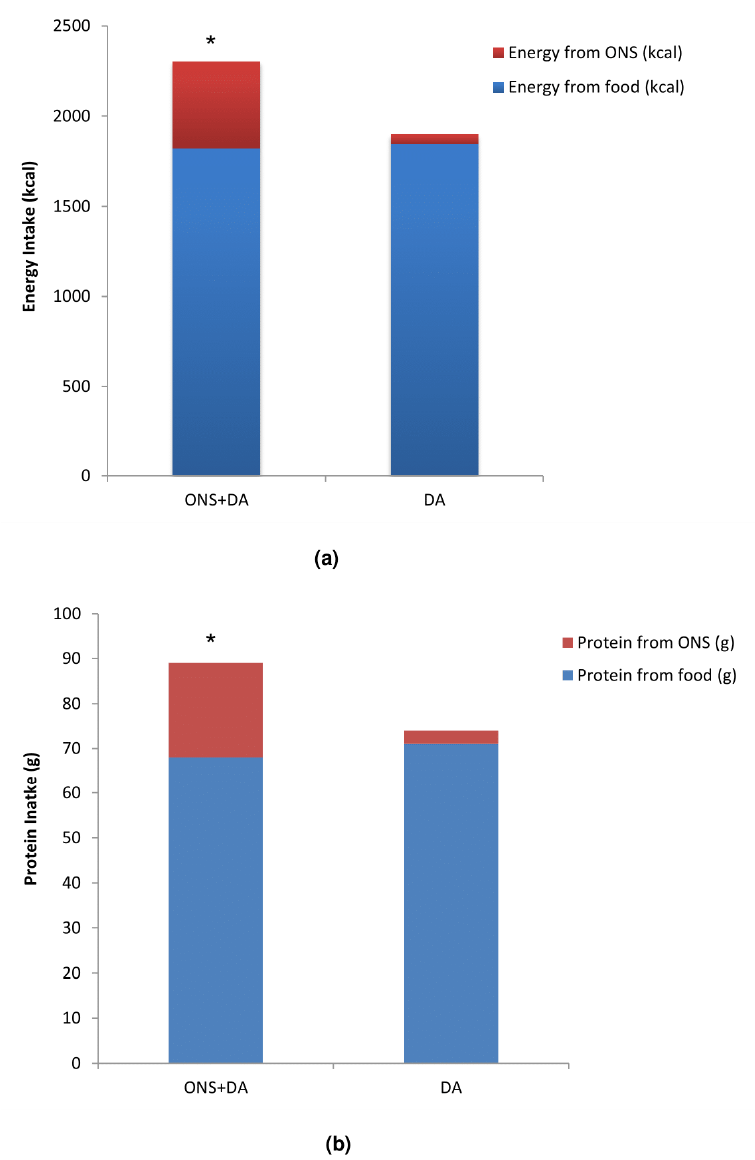
Figure 2. ( a ) Mean daily energy intakes according to intervention group; ( b ) Mean daily protein intakes according to intervention group; Univariate analysis adjusted for the baseline value, MUST category, CCI, age and gender. Data presented as mean ± SE, * p < 0.001. 4 participants in the DA arm reported taking over the counter ONS contributing to their intake. DA, dietary advice. ONS, oral nutritional supplement.